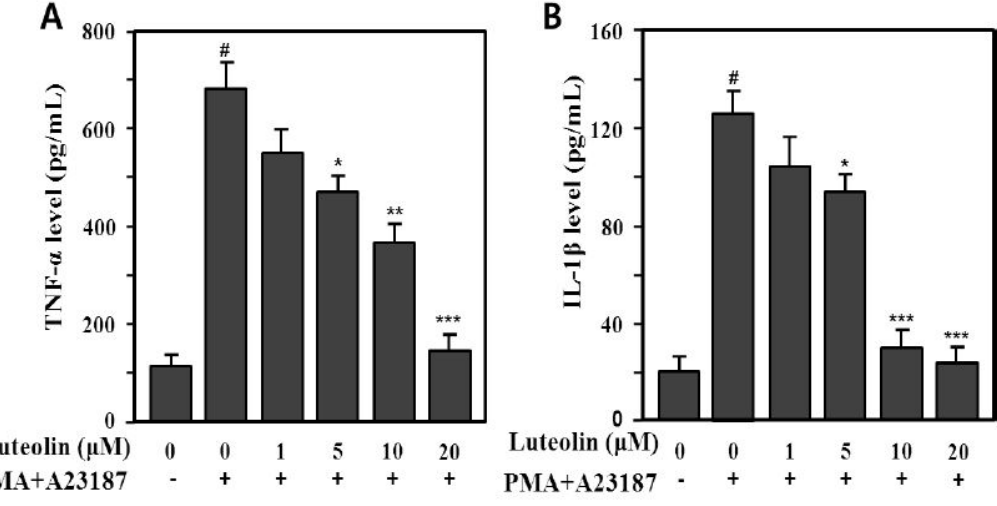
Figure 3. Inhibitory effect of luteolin on PMA plus A23187-induced TNF- α ( A )- and IL-1 β ( B ) production in HMC-1 cells. Cells (5 × 10 5 ) were pretreated with 1–20 μ M luteolin for 30 min prior to stimulation with or without 25 nM PMA plus 1 μ M